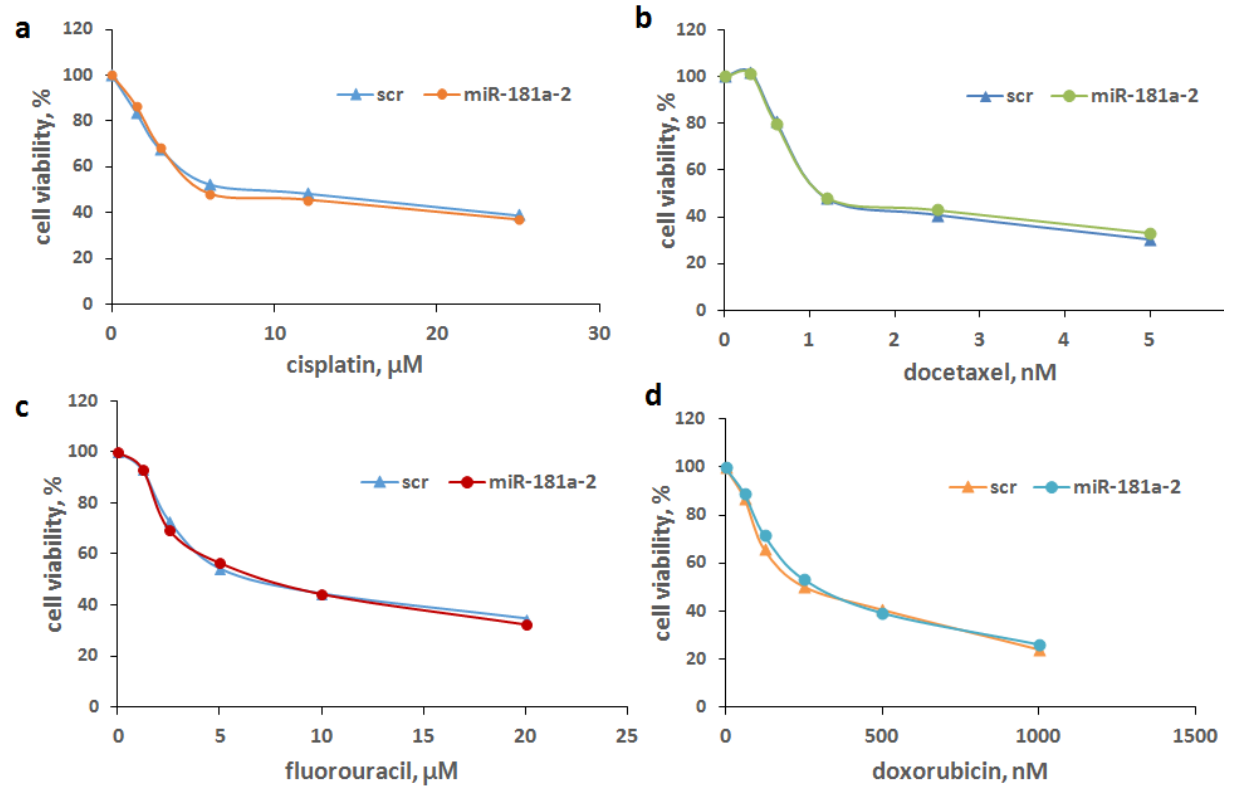
Figure 4. Drug sensitivity of the miR-181a-2-multiple transfected cells. The multiple-transfected MCF7 cells were obtained as indicated above. The cell sensitivity to cisplatin ( a ), docetaxel ( b ), fluorouracil ( c ) and doxorubicin ( d ) was determined by the MTT test. Data represent the mean value ± SD of three independent experiments.